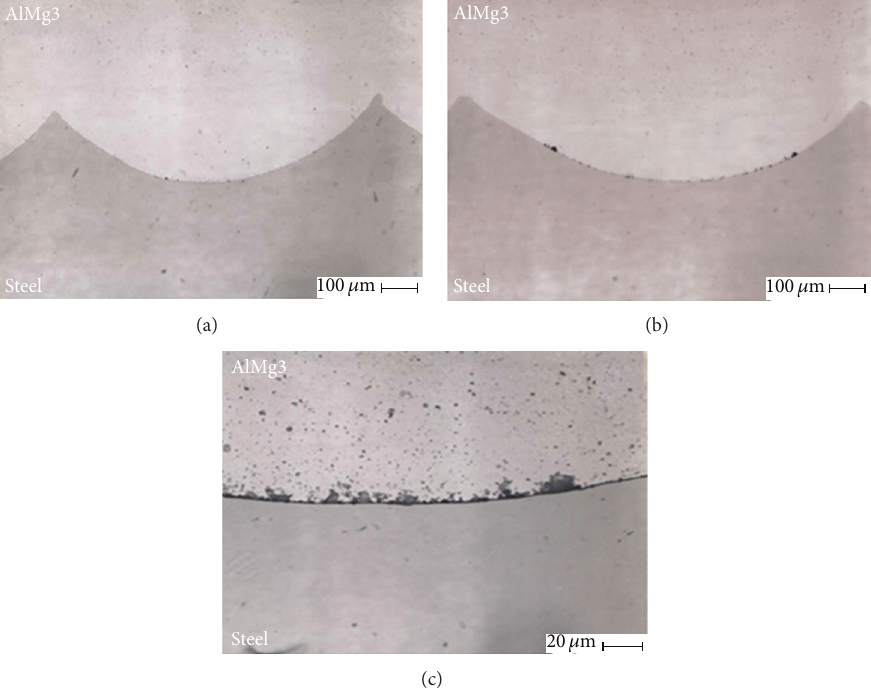
Figure 13: The view of a bond zone of friction welded AlMg3 aluminium alloy-austenitic steel joints (light microscope, nonetched specimen, sample no. 2 (a), sample no. 3 (b), and an enlarged fragment of the b (c) (according to